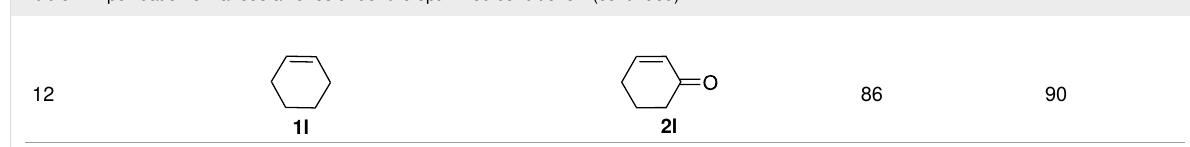
Table 2: Epoxidation of various alkenes under the optimized conditions. a (continued)